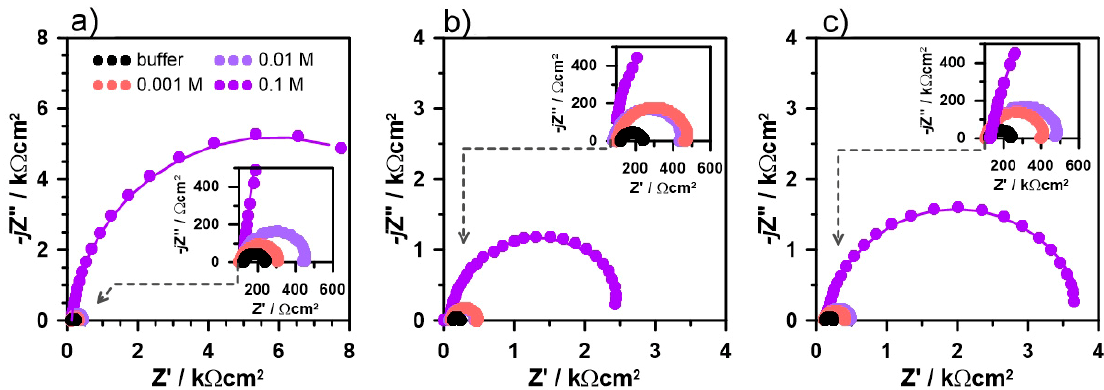
Figure 3. EIS impedance spectra recorded for AA5754 exposed to bicarbonate buffer (pH = 11) with the addition of the studied dihydroxybenzene isomers: ( a ) resorcinol; ( b ) catechol; ( c ) quinol at various concentrations in range 1–100 mM.